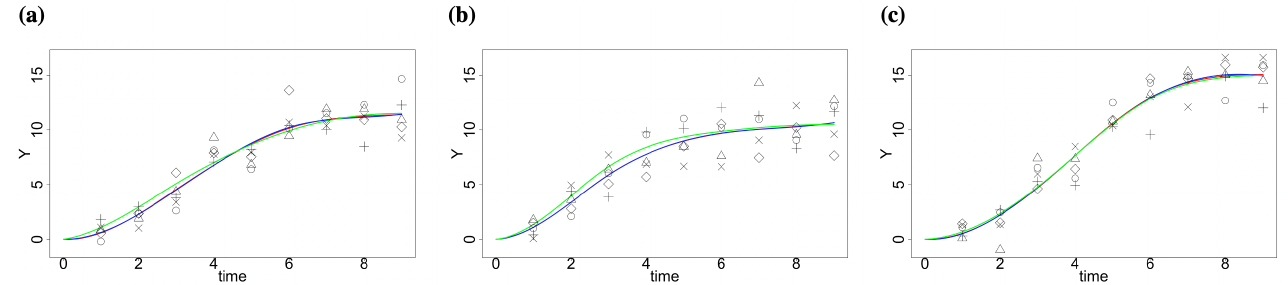
Figure 1. Simulated data and estimation by the standard least square procedure and quadratic programming framework for different factors; true data are denoted by different types of points; the true curve µ ( t ) is marked in green; fitted curves with linear constraints are in red, while the fitted curves by standard least square procedure are in blue ( a ) Factor 1, ( b ) Factor 2 and ( c ) Factor 3.